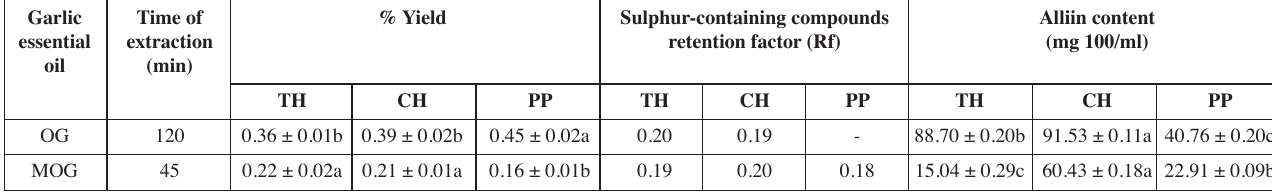
Tab. 4: Quantitative and qualitative comparisons of sulphur-containing compounds in garlic bulbs Thai, Chinese and Pingpong cultivars